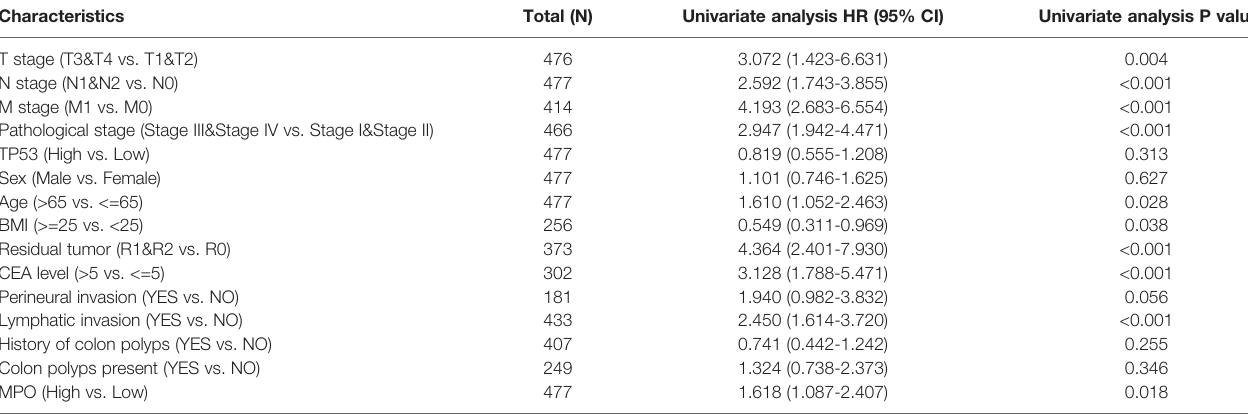
TABLE 3 | Univariate analysis of prognostic factors for OS with the Cox regression model.